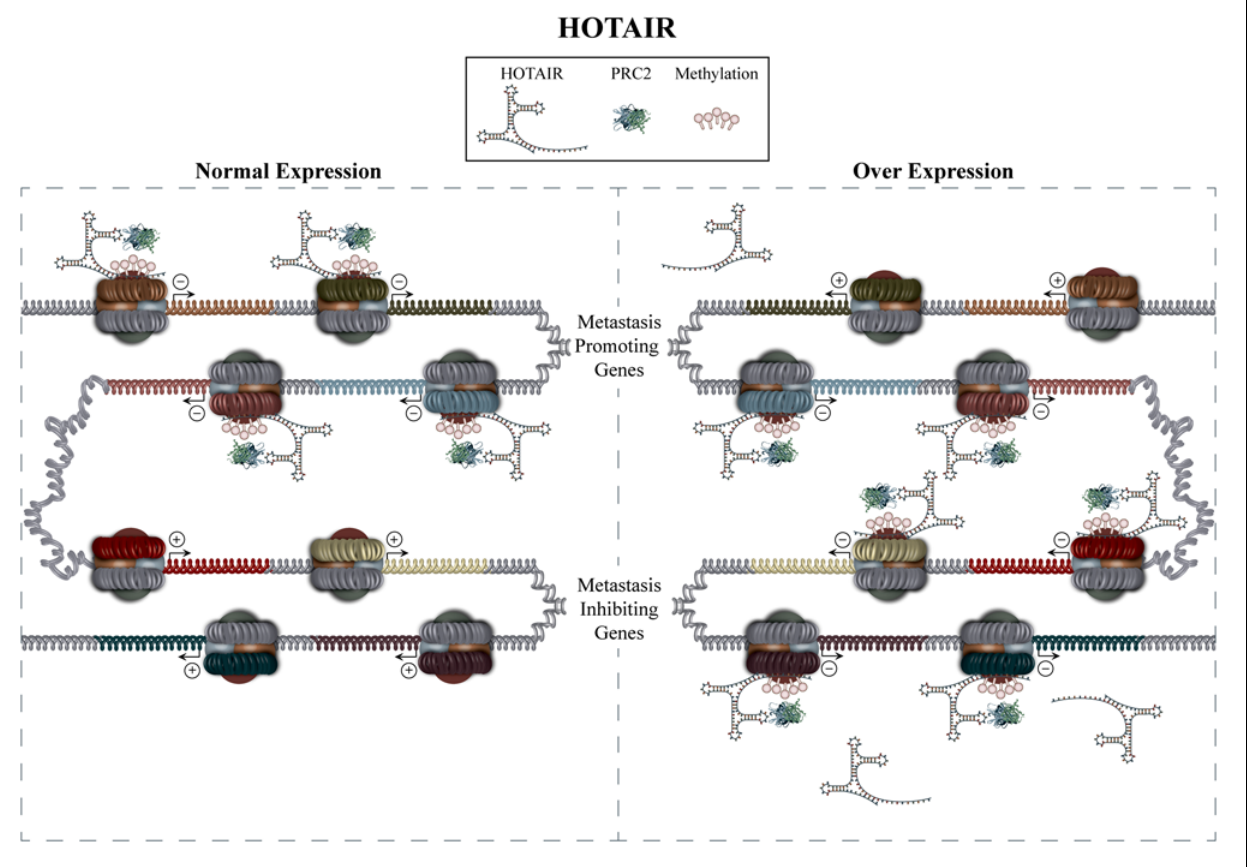
FIGURE 2 | Hox antisense intergenic RNA mediated regulation. The recruitment of PRC2 to specific gene sets is mediated by HOTAIR in trans , consequently increasing methylation and inactivation of the targeted genes promoters. Overexpression of HOTAIR causes PRC2 to